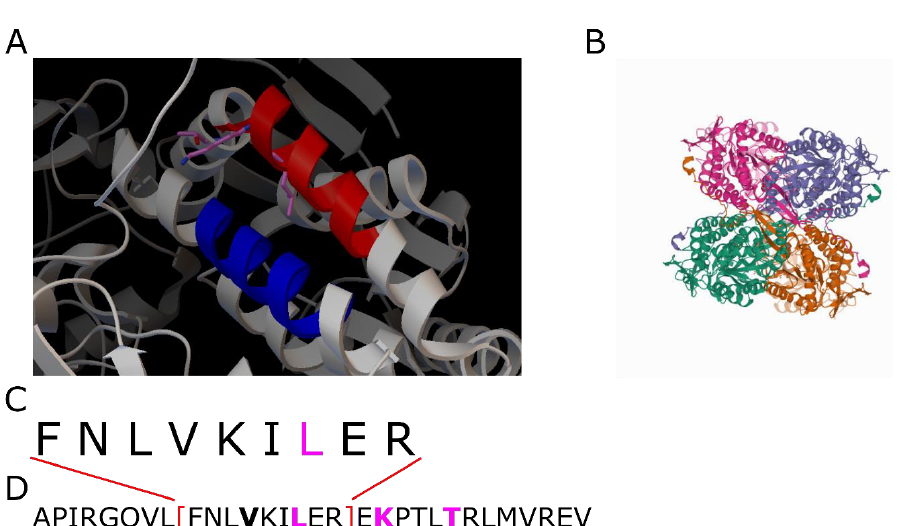
Figure 7. PDB-ID 6fjx. ( A ): Detailed view on the coiled coil. The red α -helix exhibits the demanding [3, 4, 4]-decomposition. The blue α -helix is the interaction partner for the formation of the coiled coil. ( B ) Shows a total view on the protein with different colors for its subunits. ( C ): Amino acid sequence of the coiled-coil range analyzed by the CCdb. ( D ): Complete sequence of the α -helix. Contact residues of the coiled coil are bold. The contact residues of the [4, 4]-repeat are colored in magenta, corresponding to ( A